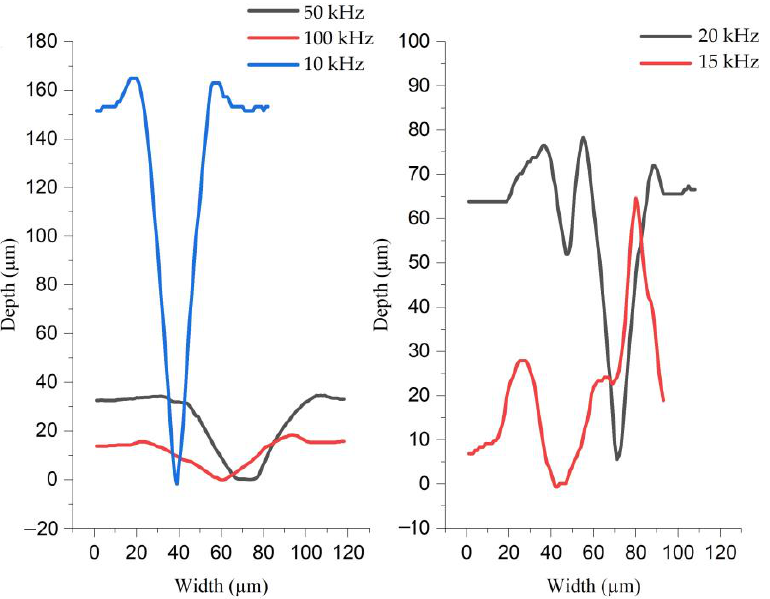
Figure 5. 2D microscope profiles from the lowest RFP 2 , RRL = 50 kHz, to the highest, 15 kHz.